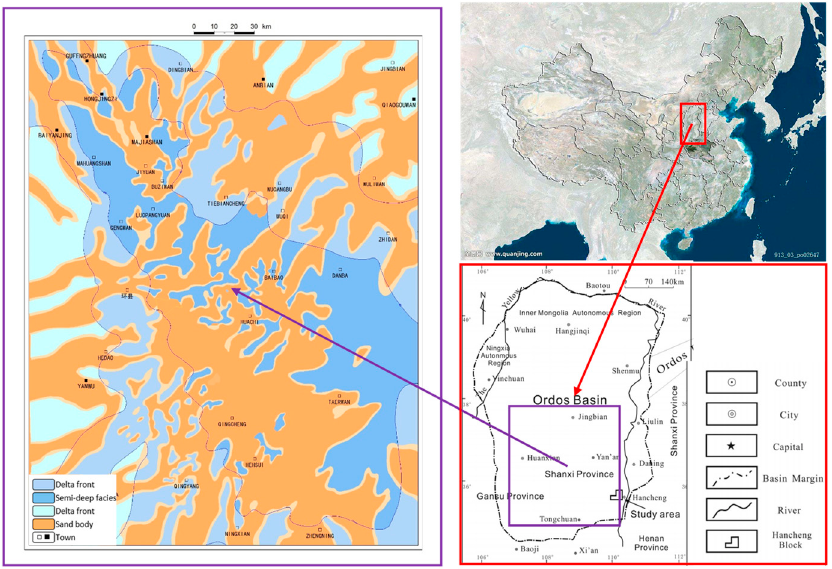
Figure 2. Location of the Ordos Basin together with typical sedimentary facies and sand body distributions of the Chang 7 tight oil reservoir, the Changqing oilfield.